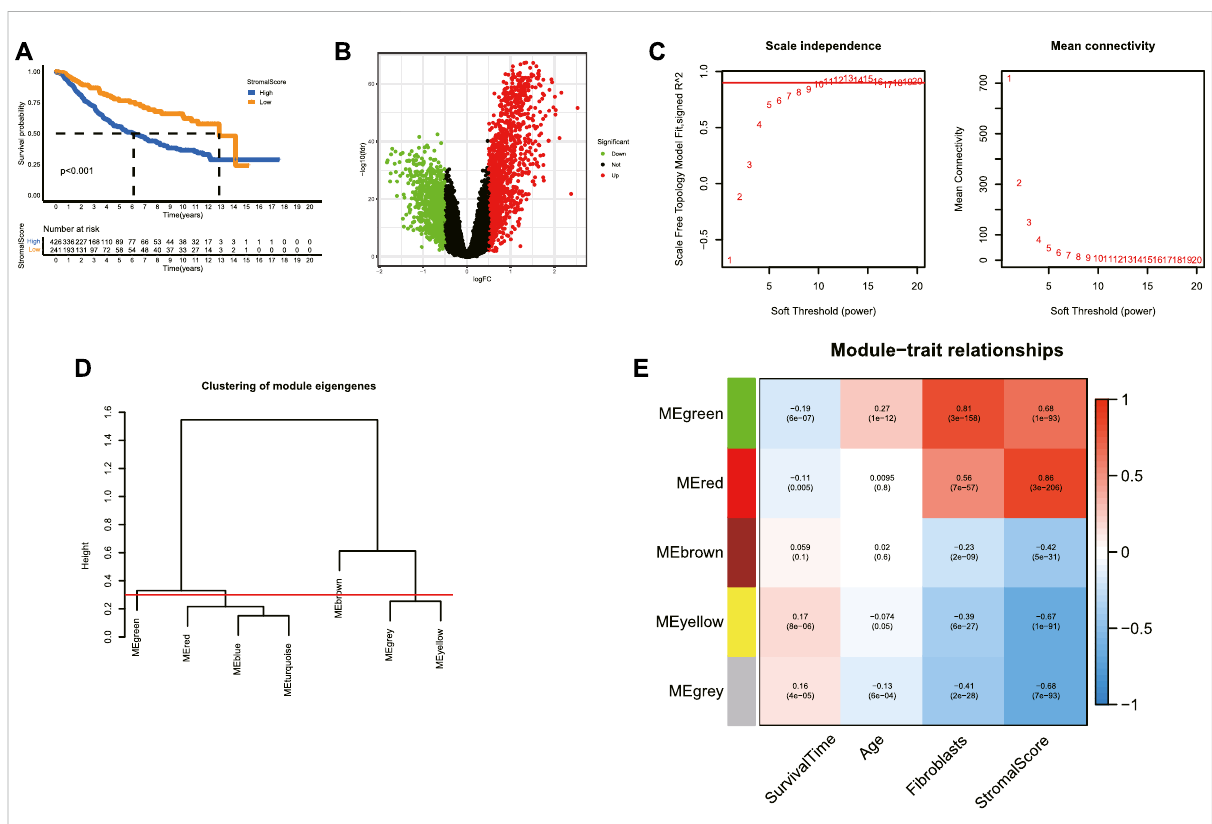
FIGURE 1 DeterminationofACAFRGs. (A) Kaplan – MeiersurvivalanalysisforLGGpatientsassignedtohighandlowstromalscores( p < 0.001). (B) Volcano plot of the DEGs between high- and low-stromal score groups. Genes with |log 2 FC (fold change)| > 0.5 and adjusted p -values (FDR, false discovery rate) < 0.05 were considered signi fi cant. Green dots represent downregulated genes in the high-stromal score group and red dots represent upregulated genes in the high-stromal score group. (C) Scale independence index and mean connectivity values when soft threshold (power) ranges from1 – 20. The redline wassetat0.90. (D) Clusteringofthemoduleeigengenes.The cutheight wassetat0.30as depictedwith theredline. (E) Heatmapdemonstratingthekeygenemodulesassociatedwithsurvivaltime,age, fi broblasts,andstromalscores.Pearsoncorrelationcoef fi cients and p -values were shown in cells. ACAFRGs, aging cancer-associated fi broblast related genes; PCA, principal component analysis; LGG, low-grade glioma; DEGs, differentially expressed